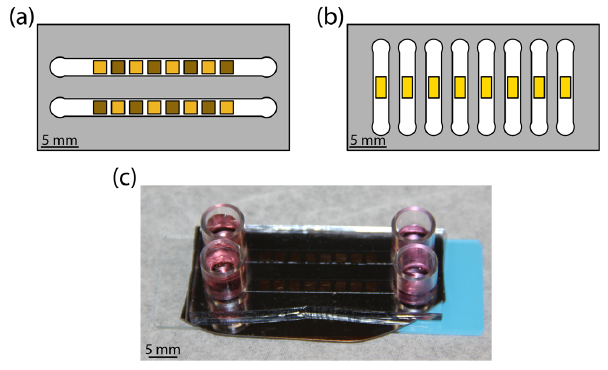
Figure 1. Illustration of the microfluidic flow cell. ( a ) Colorized schematic of high-throughput chip with nanoporous gold (np-Au) morphology library. Gold color patterns reflect the extent of annealing, where lighter squares represent annealed np-Au and darker squares representing unannealed np-Au. ( b ) Colorized schematic of real-time experiment chip with planar gold (pl-Au) substrate. ( c ) Photograph of a representative assembled np-Au chip with culture media in reservoirs. The microchannel height was obtained by profilometer measurements and was 138.0 µm on average, with a standard deviation of 0.3 µm. Channel lengths were 40 mm for the high-throughput chip and 22 mm for the live chip. All channel widths were 3.5 mm. The maximum shear stress obtainable by syringe pump-driven flow was nominally 200 dyne/cm 2 , which was lower than